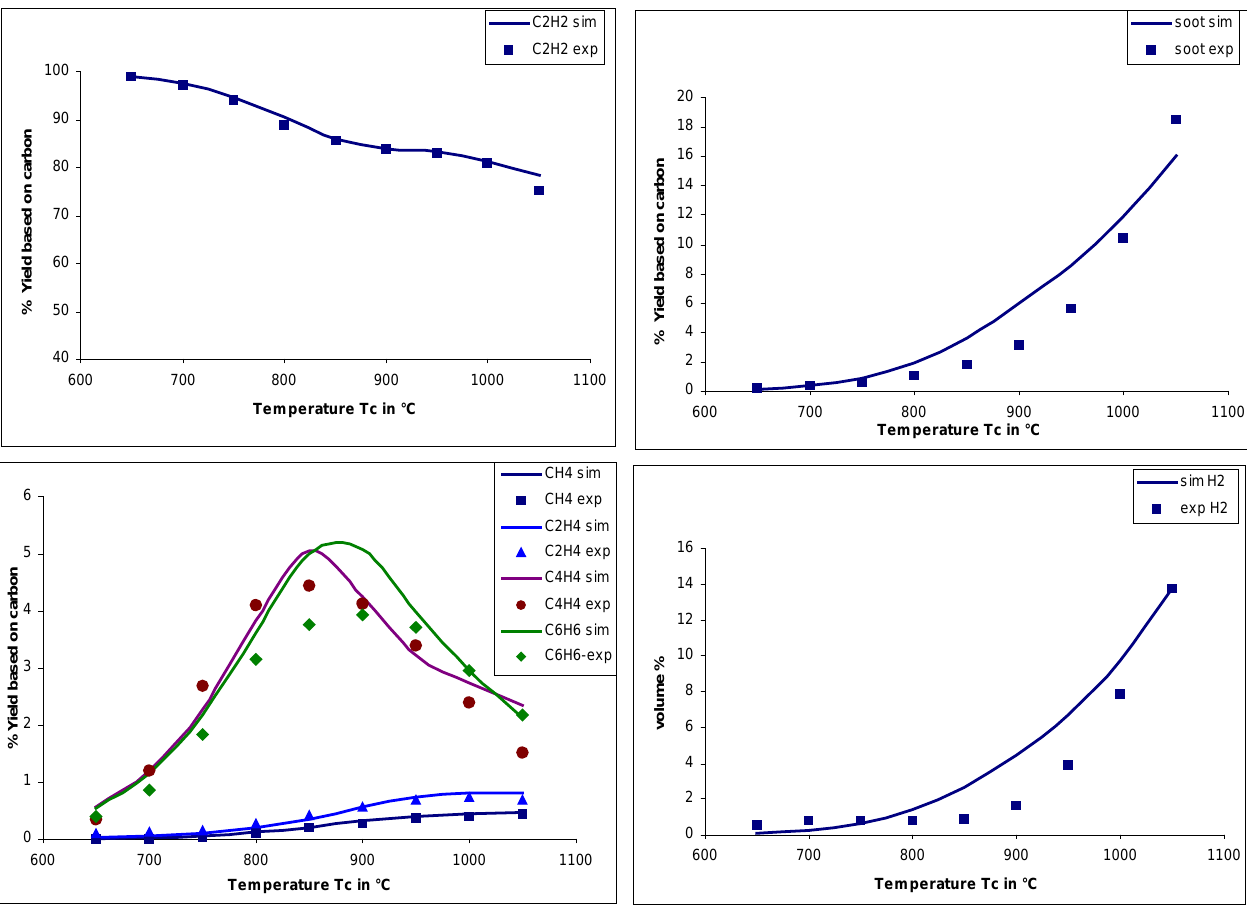
Figure 5. Comparison of simulated vs experimental results at 20 mbar acetylene partial